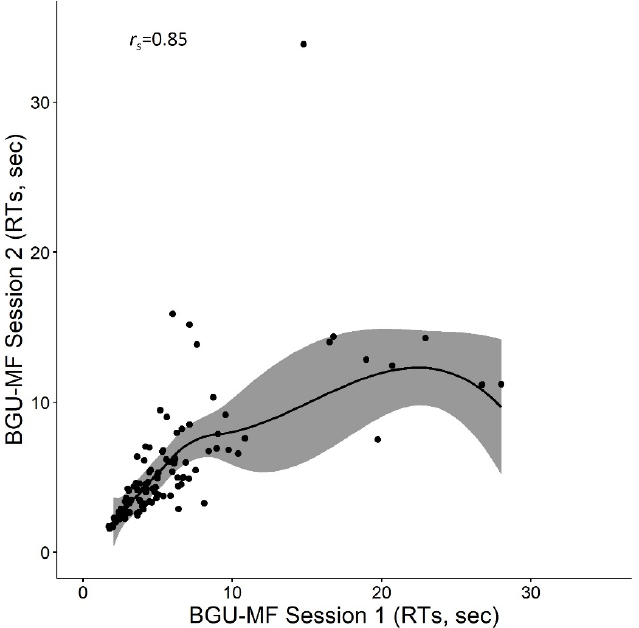
Figure 4. Correlation between RTs in the first and second sessions in the BGU ‐ MF.